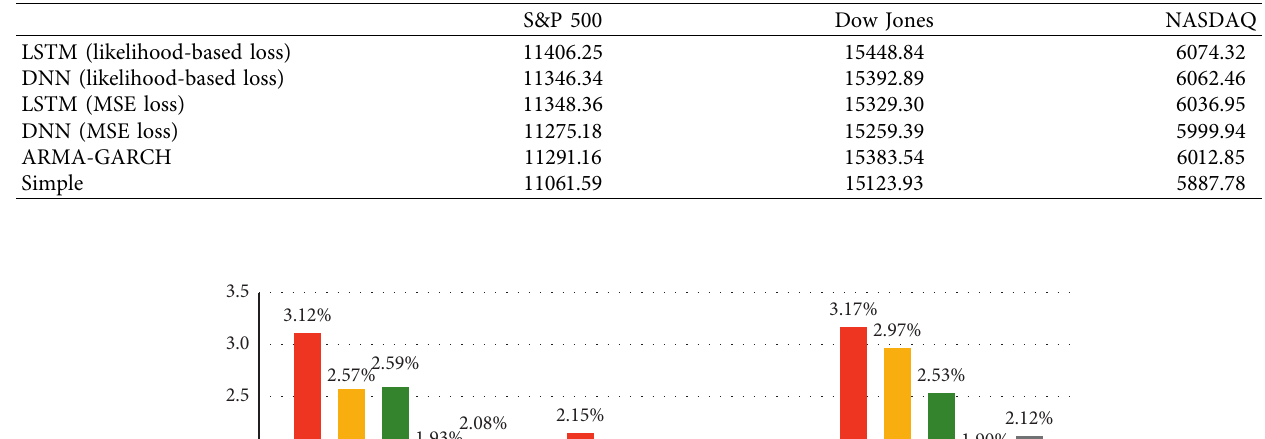
Table 5: Log likelihoods of the test sample.